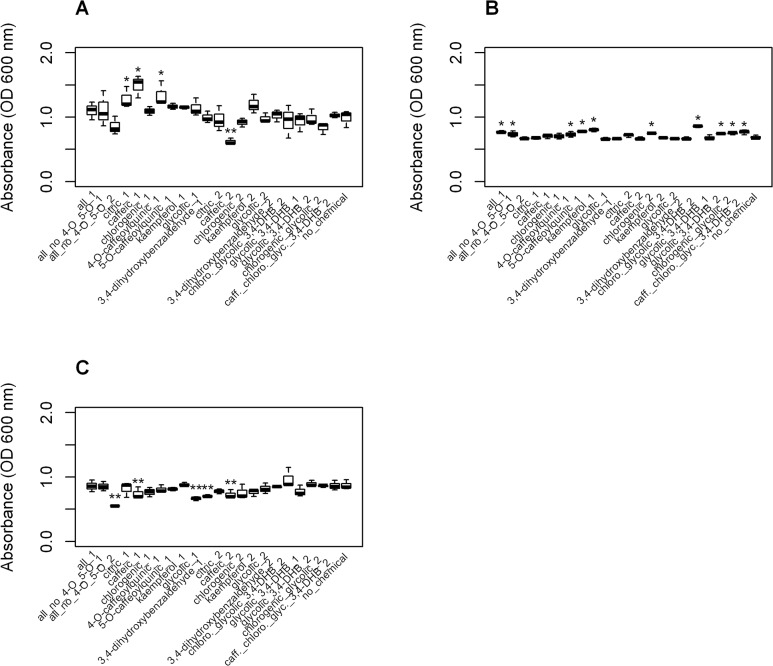
Growth of methicillin-sensitive (SA) and methicillin-resistant Staphylococcus aureus (MRSA) in the presence of single or multiple pure compounds at proportions approximated from GC-MS quantification.Growth with compounds alone or together was compared to the positive growth control (no chemical added) to determine inhibitory activity. Statistically significant differences greater (*) or less (**) than control are marked by asterisks. Concentrations follow the GC-MS quantification values in Fig 1, but in μg/ml. Growth of A. SA 27708, B. MRSA 35591, and C. MRSA 35593 are reported at 24 h.